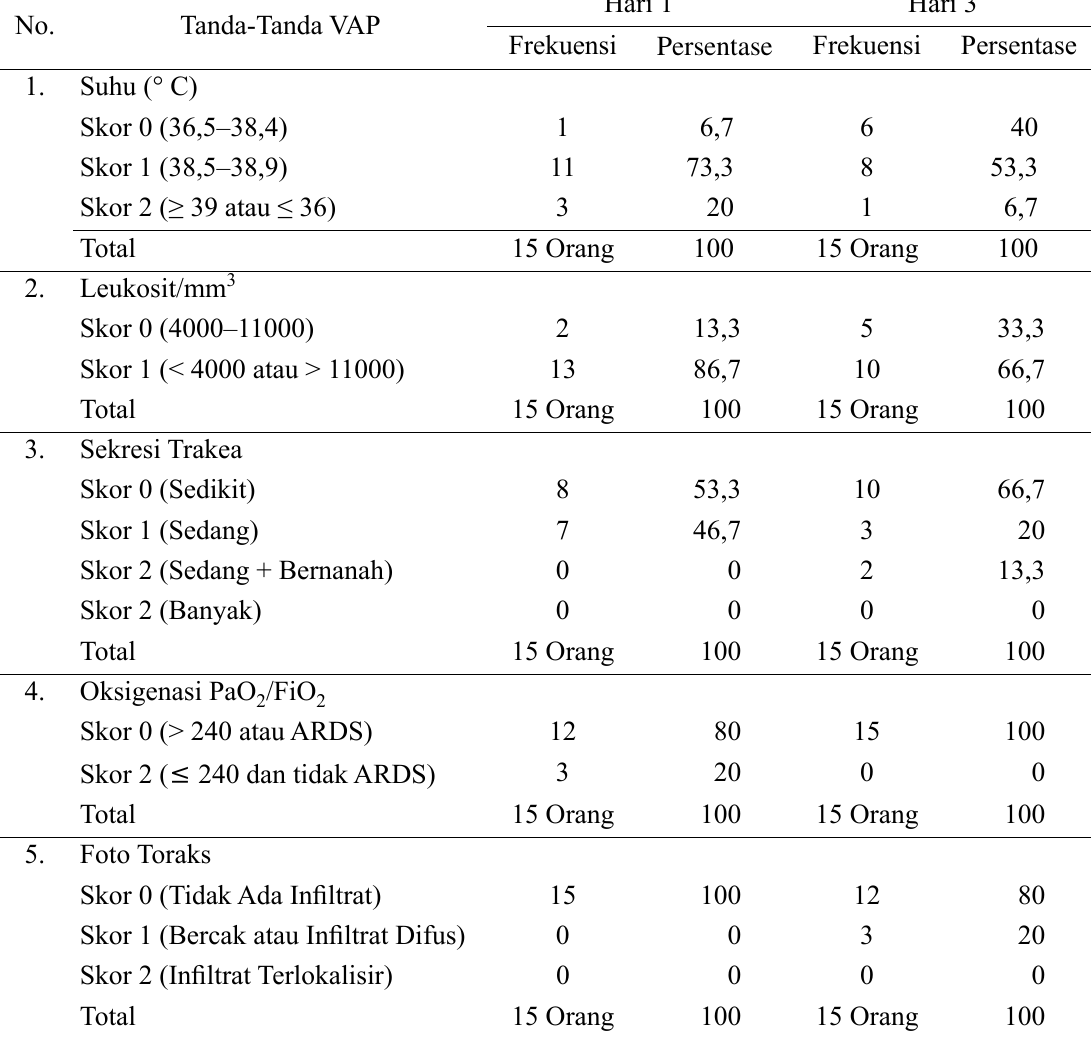
Tabel 1. Distribusi frekuensi responden berdasarkan tanda-tanda VAP hari 1 dan hari